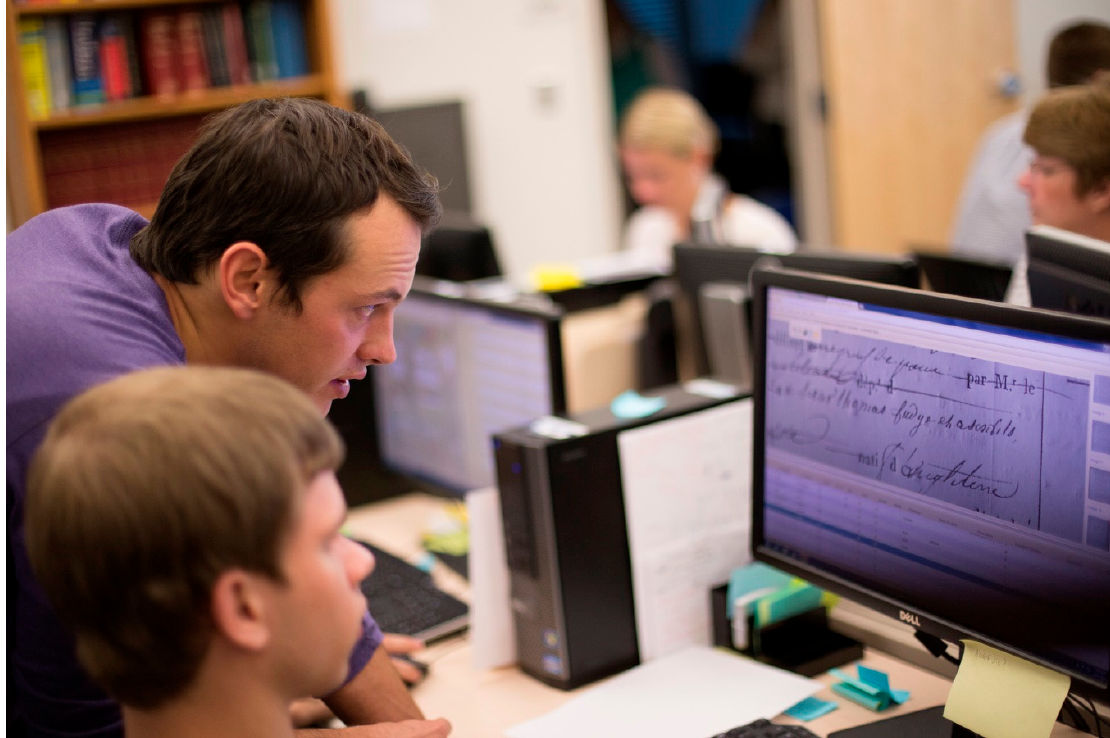
Figure 2. Student researchers working on deciphering handwritten records for the Immigrant Ancestors Project (IAP).